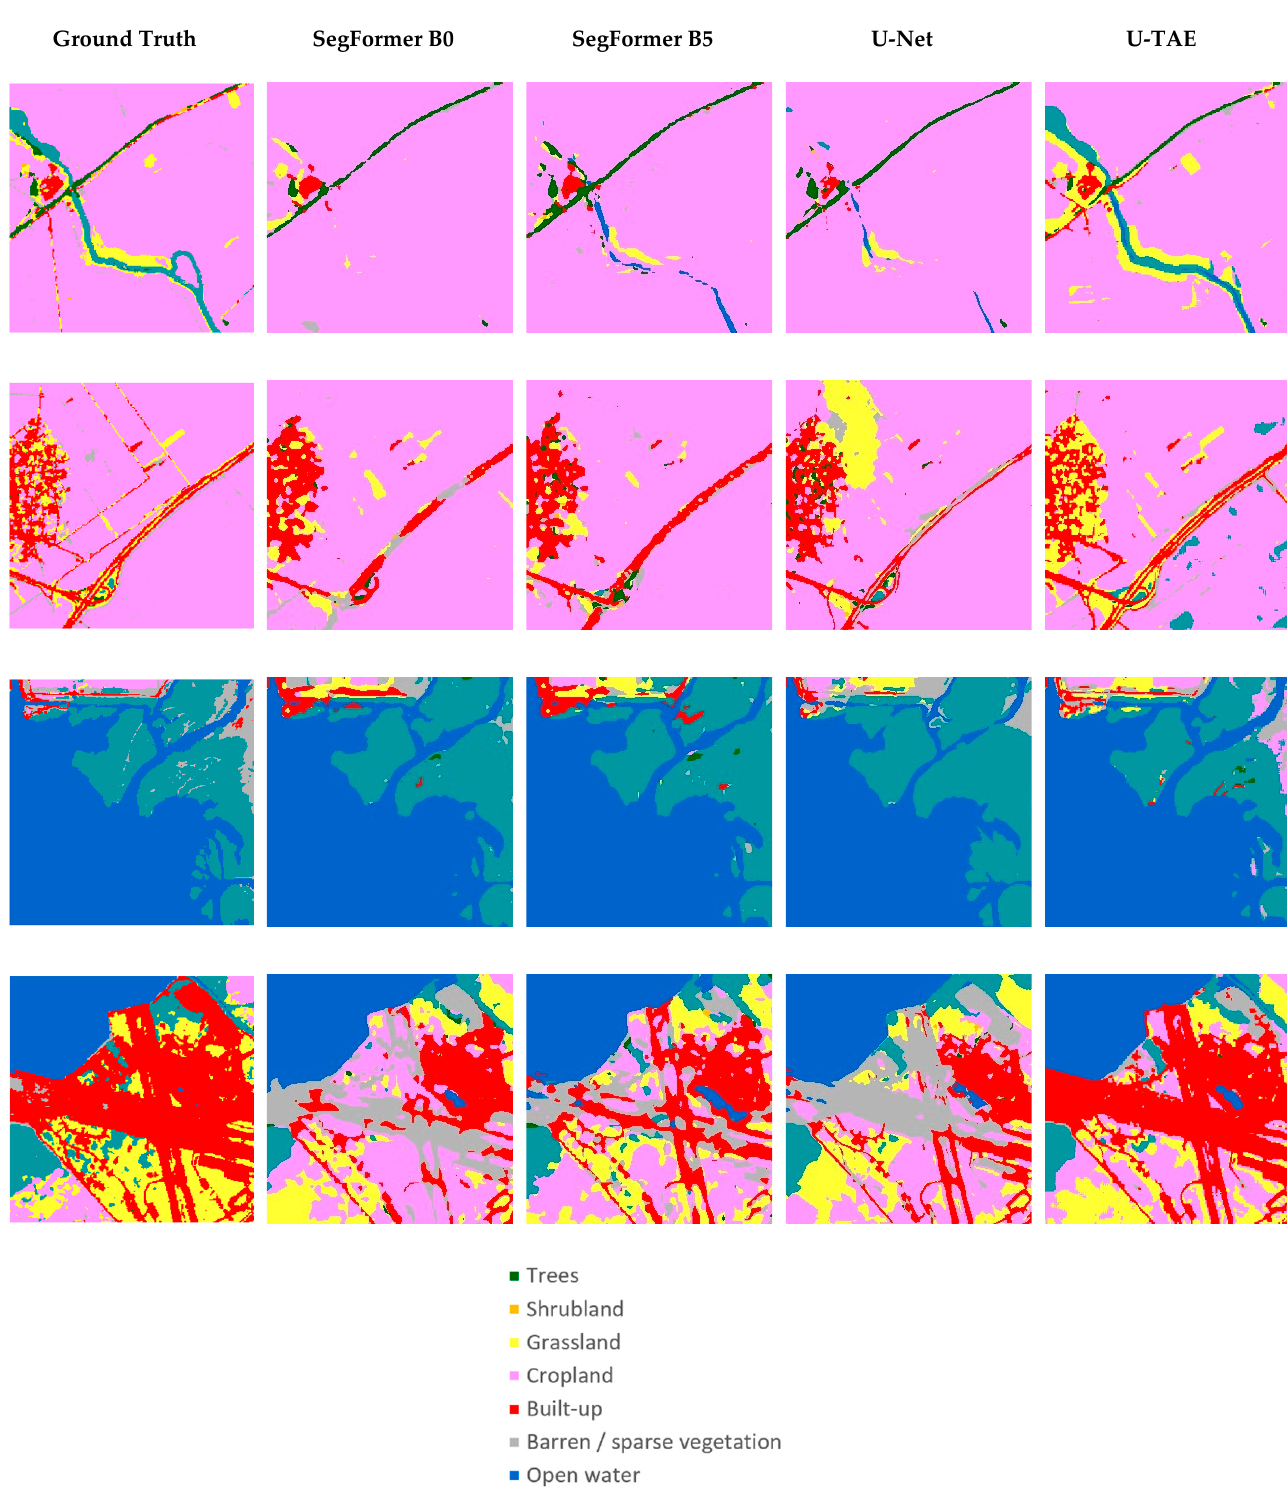
Figure 9. Segmentation map examples for selected regions of the testing dataset. From left to right: ground truth, SegFormer B0, SegFormer B5, U-Net, and U-TAE.